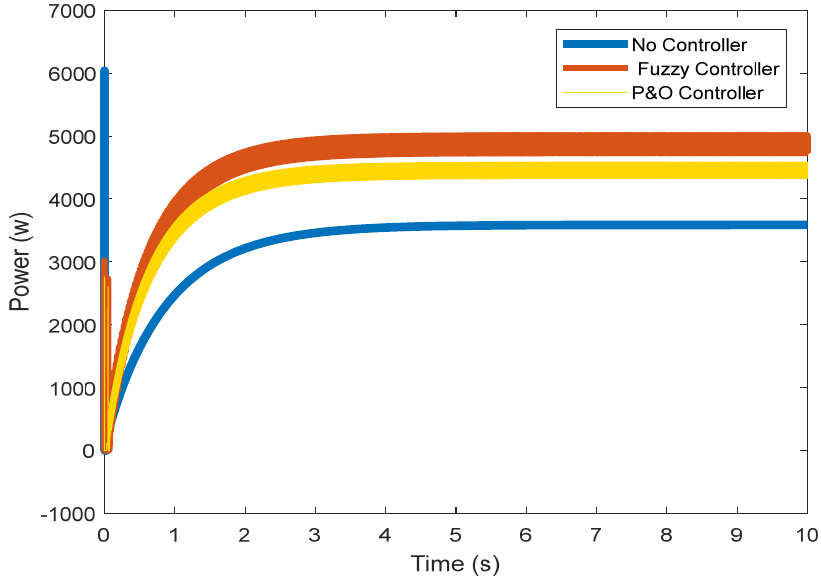
Figure 12. Output power of the fuel cell.